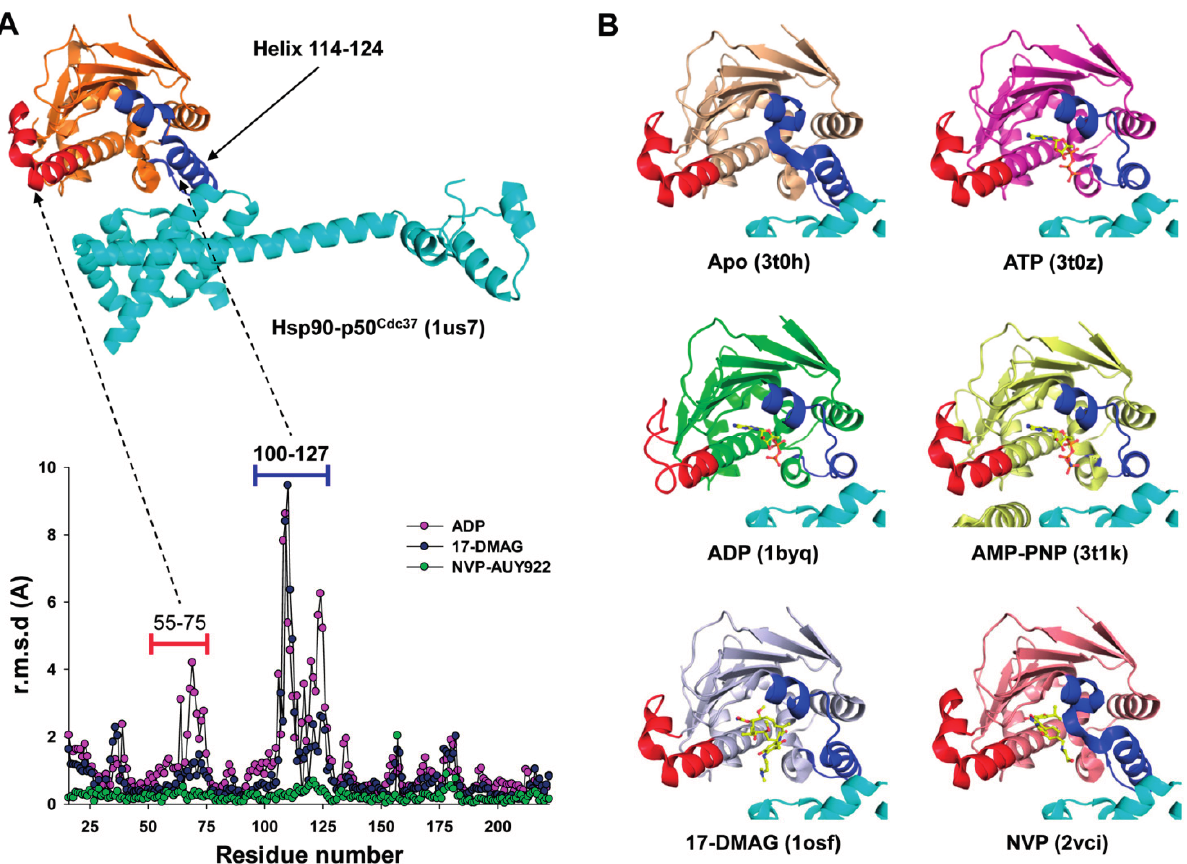
Figure 6. ADP-induced structural changes in Hsp90 may impact complex formation with p50 Cdc37 . ( A ) Root mean square deviation (r.m.s.d.) analysis of the N-terminal domain of human Hsp90 α in the ligand-free state (3T0H) against the liganded states with ADP (1BYQ), 17-DMAG (1OSF), or NVP-AUY922 (2VCI). Residues 100-127 and, to a lesser